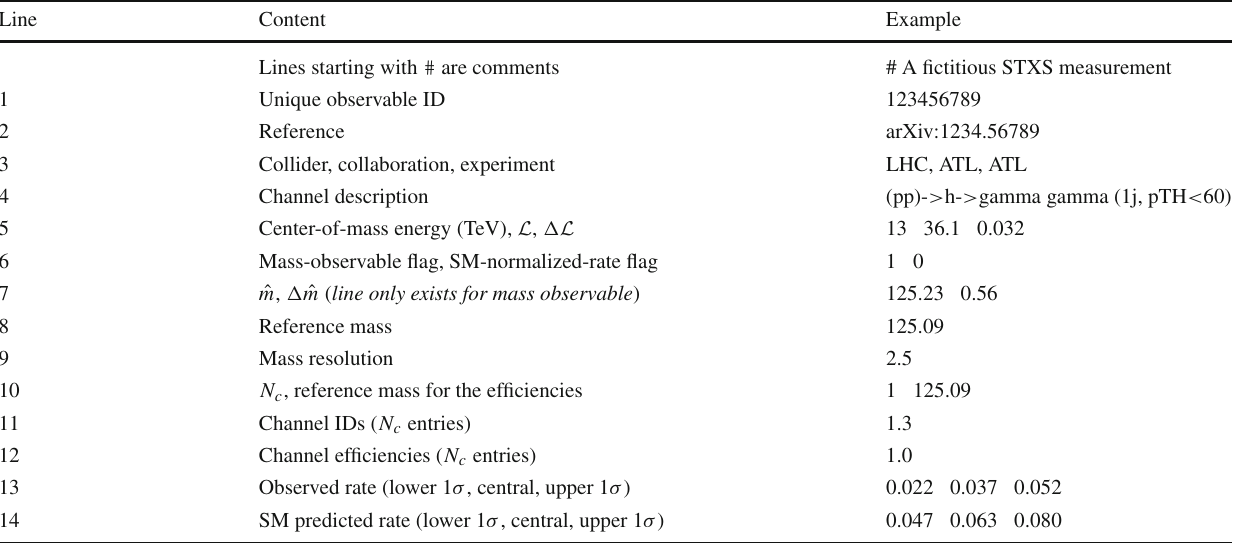
Table 5 Structure of an STXS observable implementation file for HiggsSignals . Note that line 7 is only present if the mass observ- able flag on line six is equal to 1 . L denotes the integrated luminosity